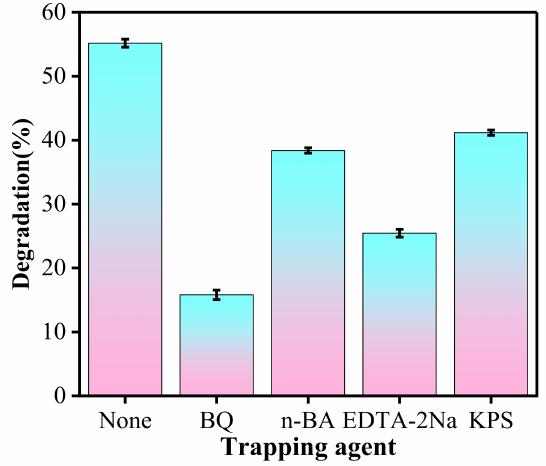
Figure 9. Radical capture experiment of 20%ZIS/CN for photodegradation of TC.